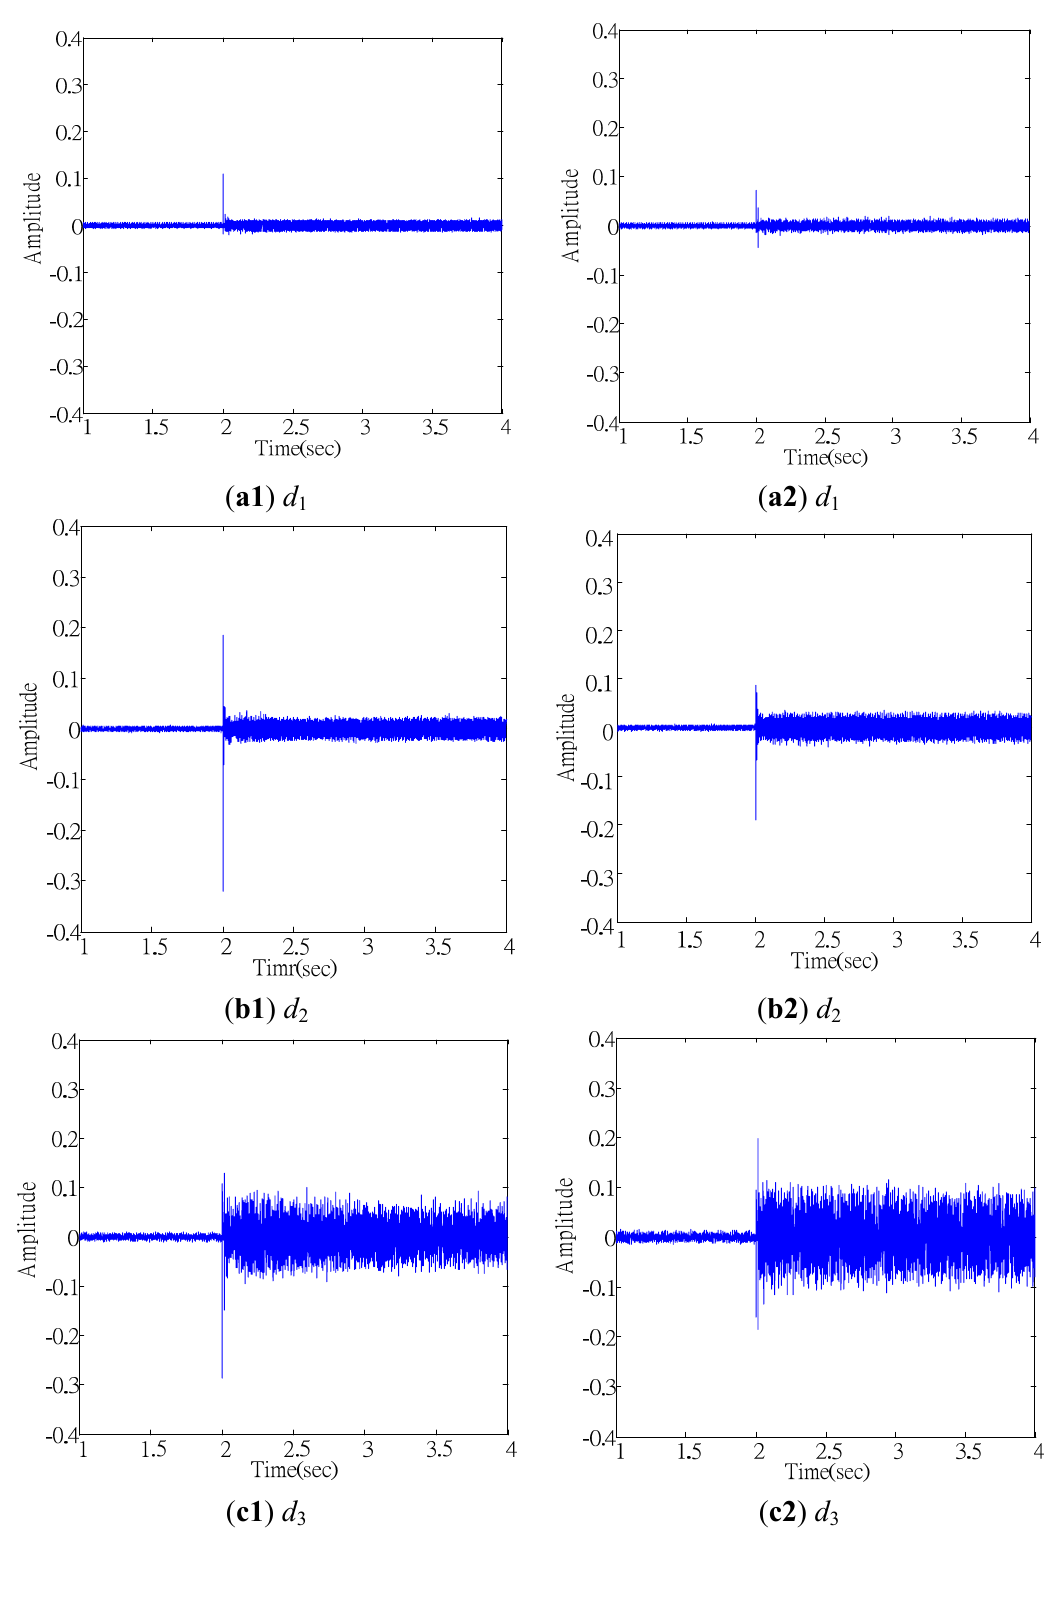
–d of voltages at point of common coupling 1 3